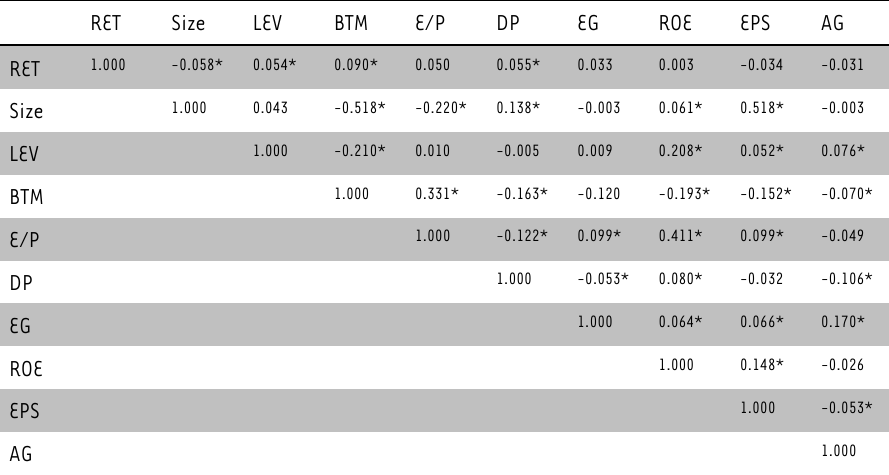
TABLE 1: Cross-correlation